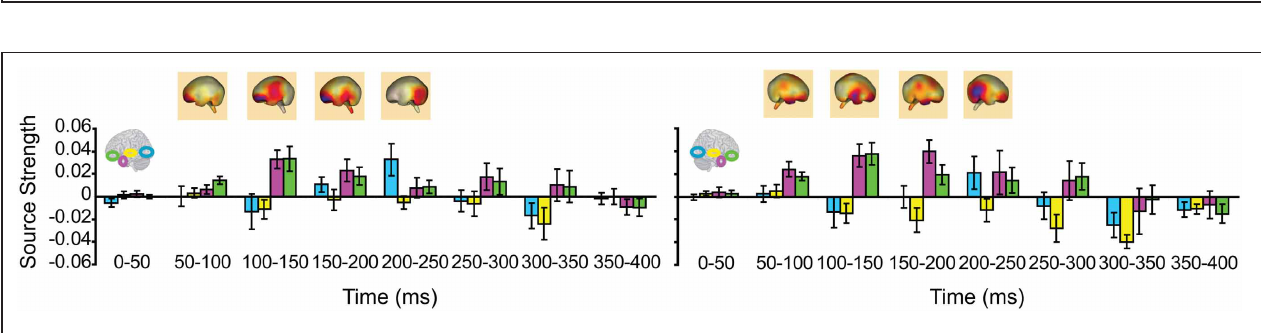
FIGURE 10 | Time-binned (50ms) audio-visual integration responses (same as in Figure 9). The top panel shows L2minimum norm images from the whole-brain, which represent unconstrained localization of the group-averaged responses, for each respective time-interval. Goodness of fit = 96.3%.